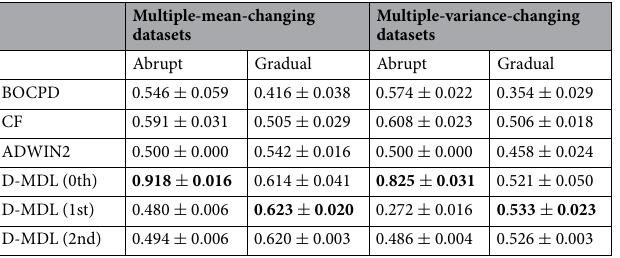
Table 1. Average AUC scores ± standard deviation on the synthetic